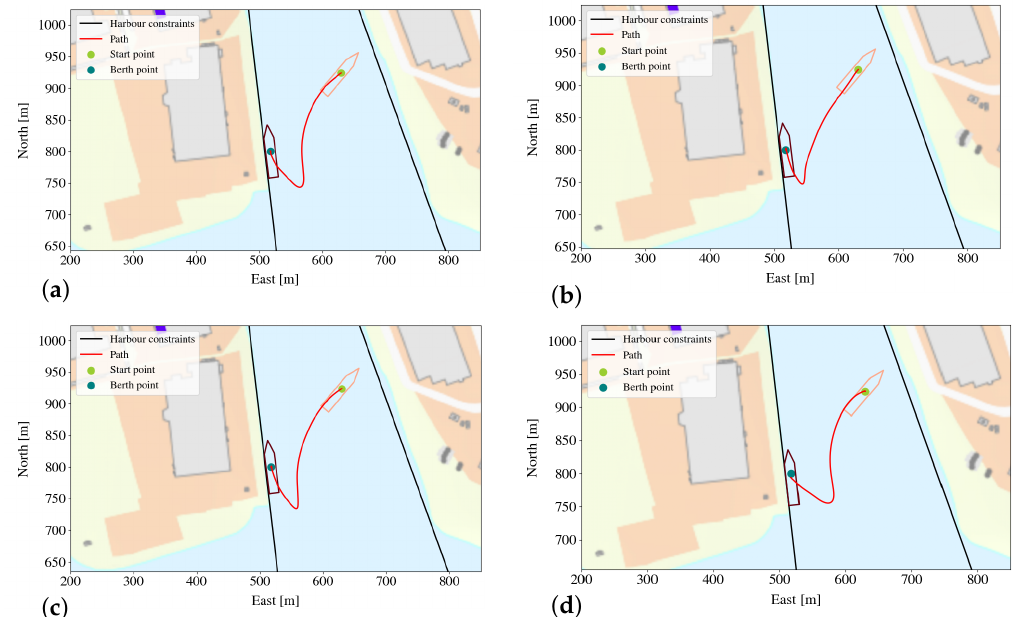
Figure 7. ( a ) Successful run by the PPO-policy, ( b ) failed run by the LMT OFS 100 , ( c ) failed run by the LMT OFS 312 , and ( d ) failed run by the LMT 467 .